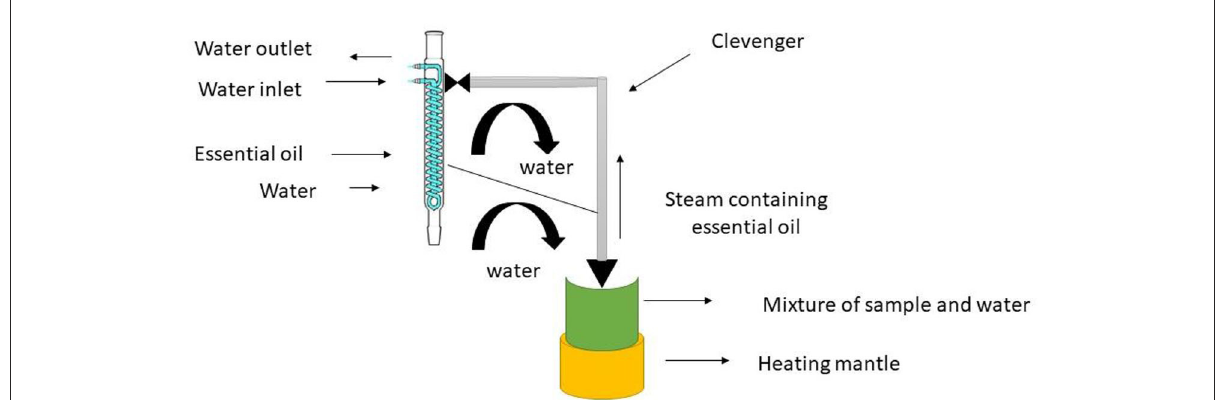
FIGURE6 Process of hydro distillation.